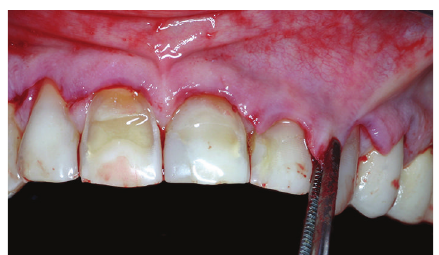
Figure 8: The flap is advanced without any tension.